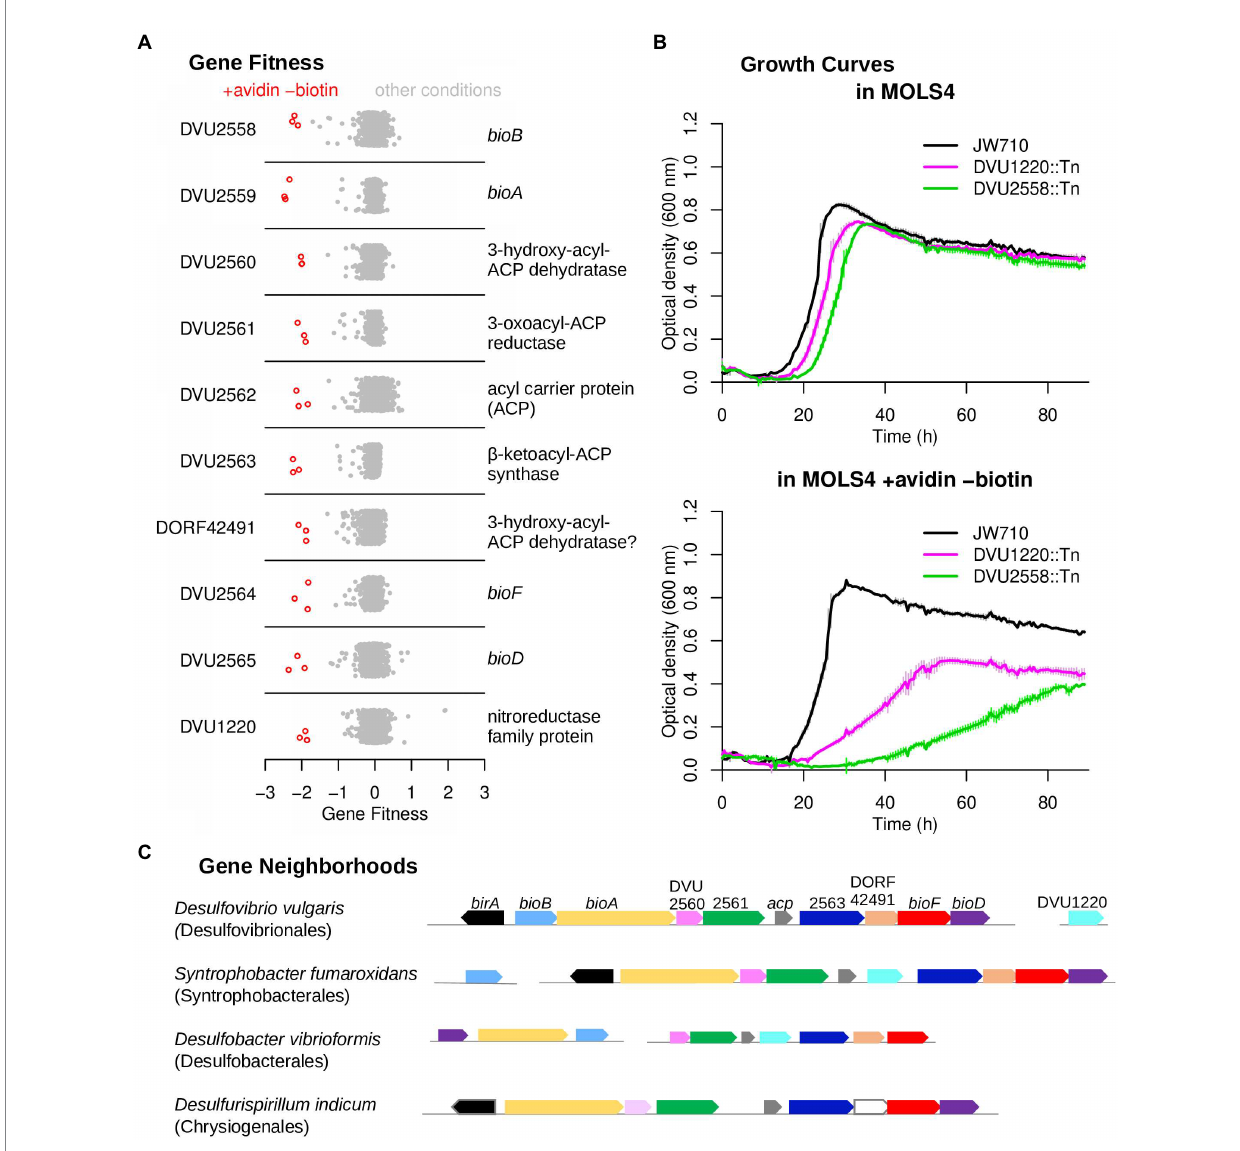
FIGURE 3 An atypical biotin synthesis pathway in D. vulgaris Hildenborough. (A) Fitness data for each gene across all 757 experiments, with experiments in the absence of biotin and supplemented with avidin highlighted. The y -axis is random. (B) Growth assays of the DvH JW710 control strain, and strains with mutations in either DVU1220 or DVU2558 ( bioB ). Measurements were made in a Bioscreen C growth analysis system and each curve is the average of four replicates. The thin vertical lines show one standard deviation on each side of the mean. (C) Gene neighborhood and conservation in other microorganisms with components of the DvH biotin synthesis pathway. Genes are colored by their homology to the corresponding DvH genes, and birA is only shown if it is adjacent to other biotin synthesis